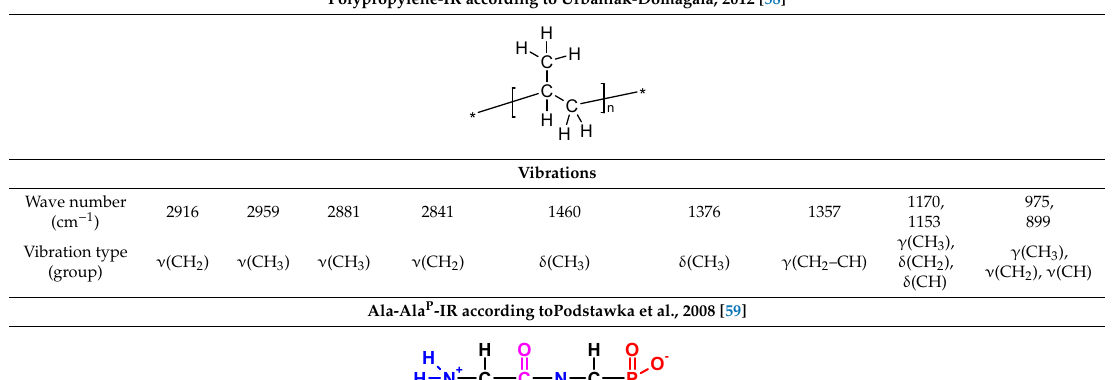
Table 5. Characteristic FTIR bands determined for Ala-Ala P , polypropylene (PP), and Ala-Ala P -polypropylene nonwoven hybrid (PP/Ala-Ala P ).